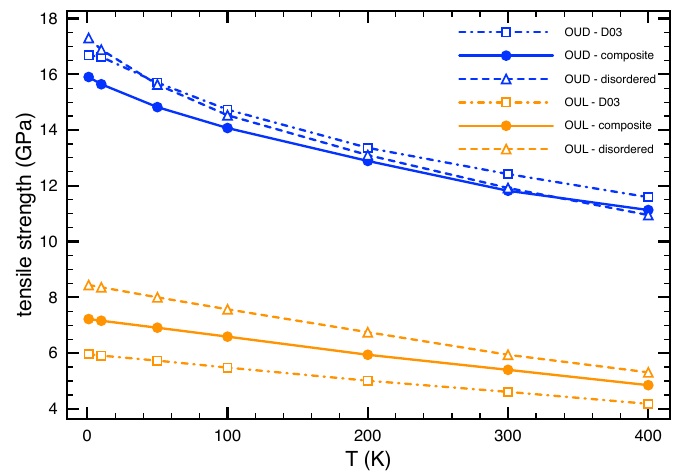
Figure 4. The tensile strength of Fe 3 Al and disordered Fe-Al phases together with their nanocomposite as functions of the temperature (the simulations were performed for 1, 10, 50, 100, 200, 300 and 400 K). Blue and yellow curves show the results obtained within OUD and OUL,